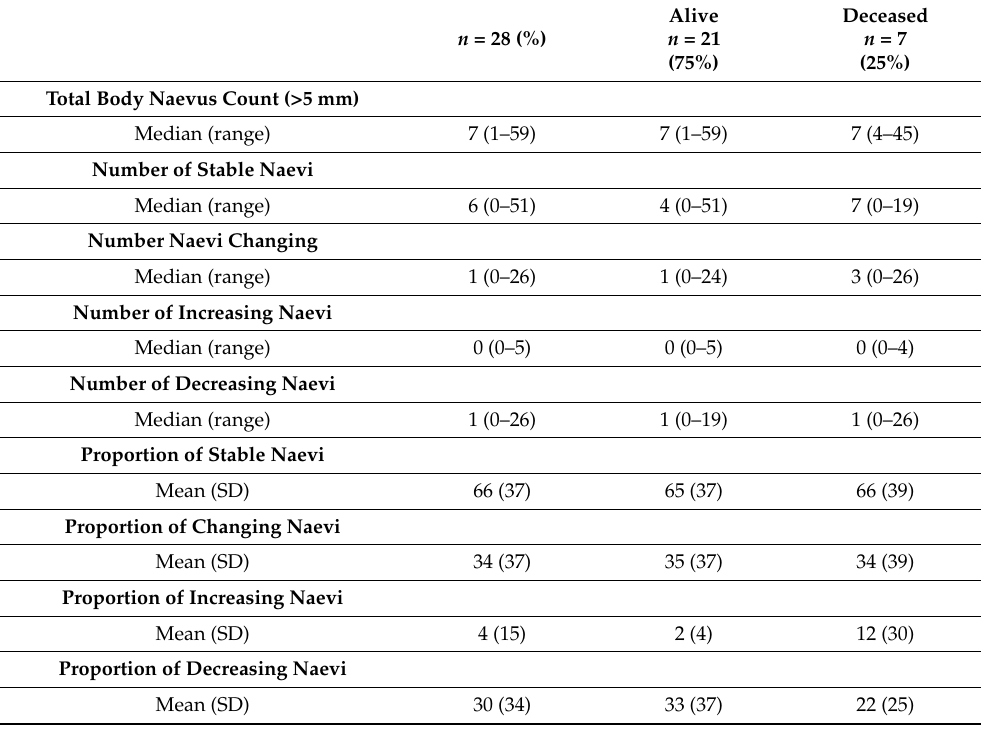
Table 3. Naevus change >5 mm for each